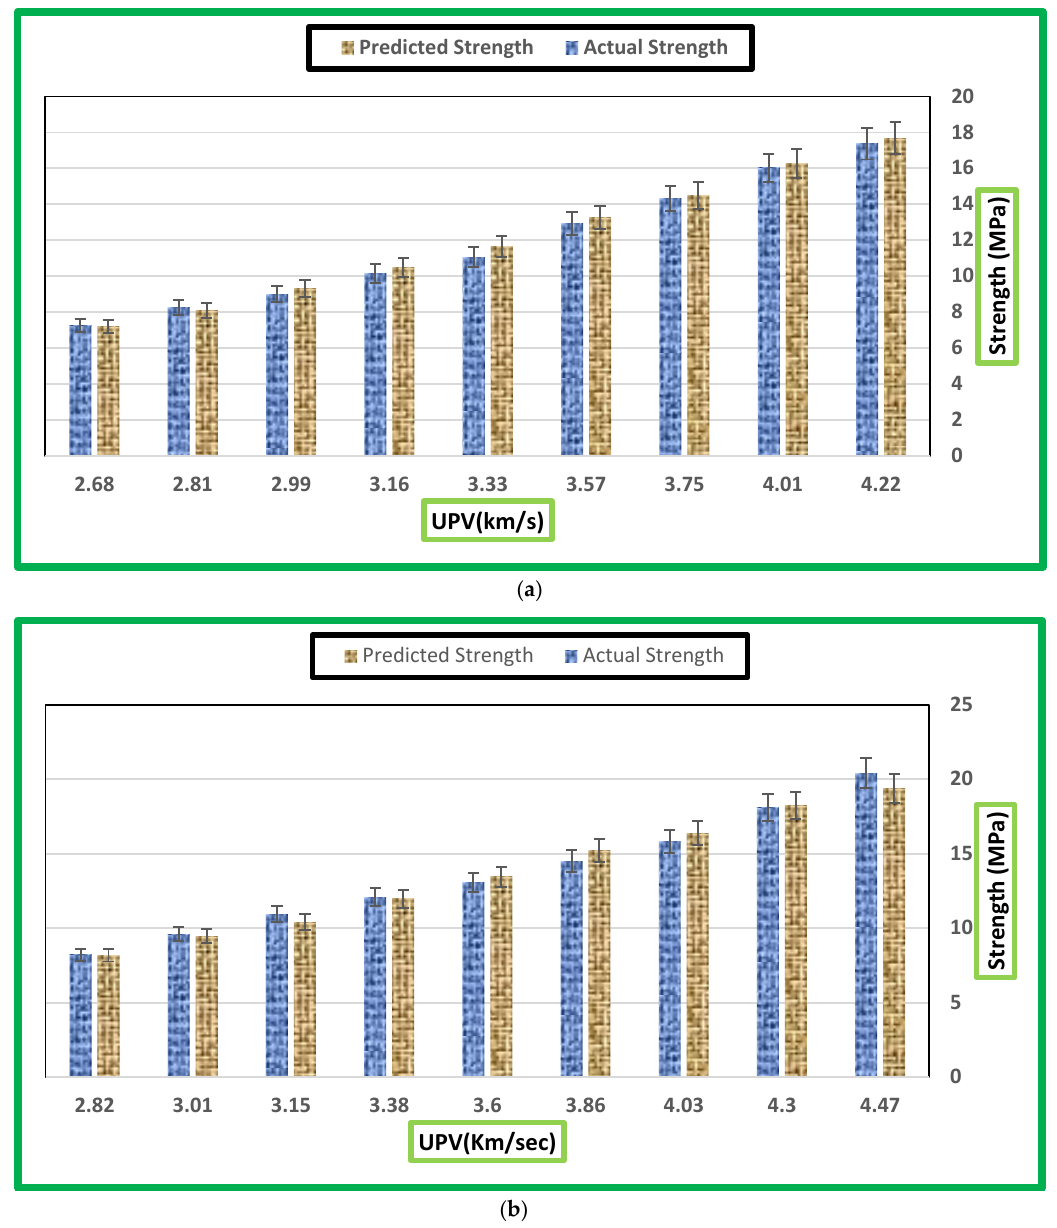
Figure 22. ( a ). Strength variations at 7 days. ( b ). Strength variation at 28 days.